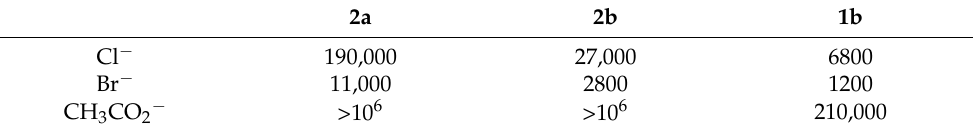
Table 1. Binding constants (K a , M − 1 ) of 2a , b and 1b [17] as a reference for various anions in CH 2 Cl 2 .